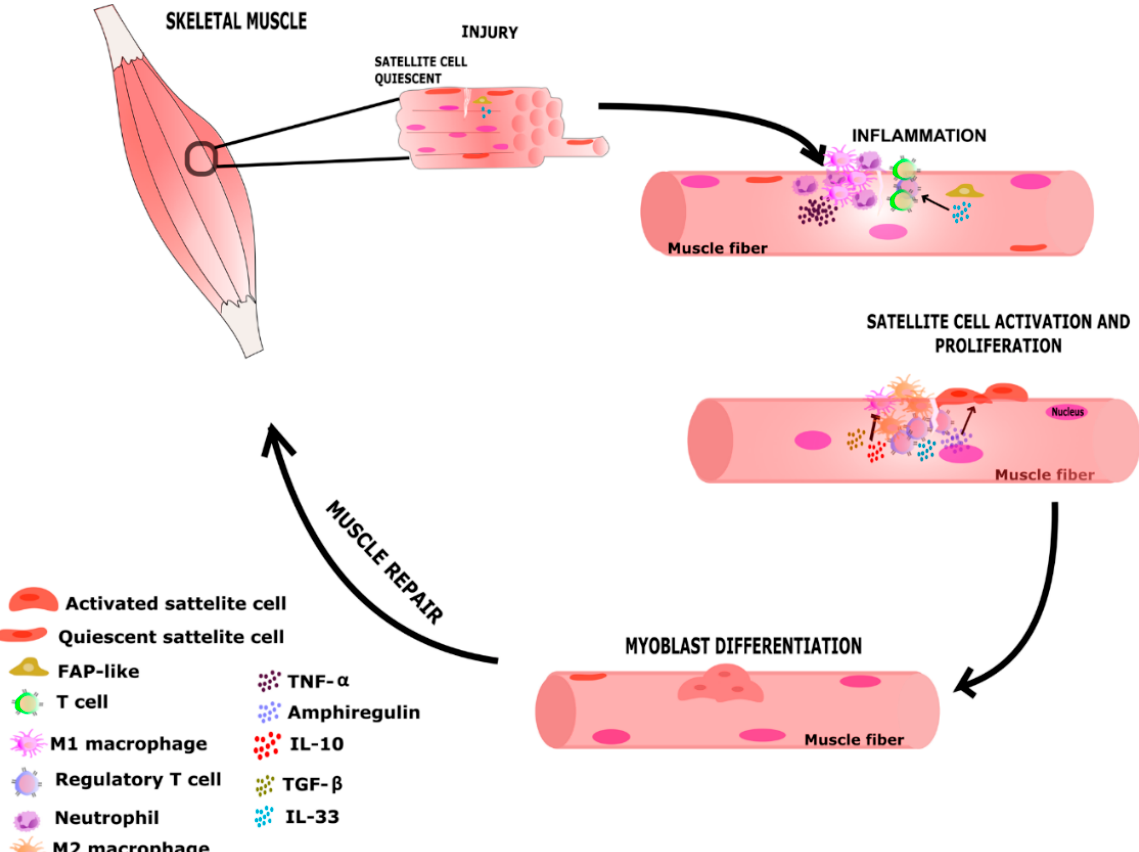
Figure 3. Illustrative image of events related to skeletal muscle acute injury. Following an acute muscle injury, a series of events are triggered in a coordinated manner to restore tissue function and promote muscle regeneration. The muscle inflammatory environment plays an important role in influencing tissue repair with participation of Treg, FAP-like, satellite cells, and soluble factors such as cytokines (e.g., IL-10, TGF- β , IL-33, TNF- α ) and growth factors (e.g., AREG). Disturbance in those events could lead to an imbalance in the regeneration process and inefficient repair of muscle tissue. FAP-like—Fibro-adipogenic precursor-like.